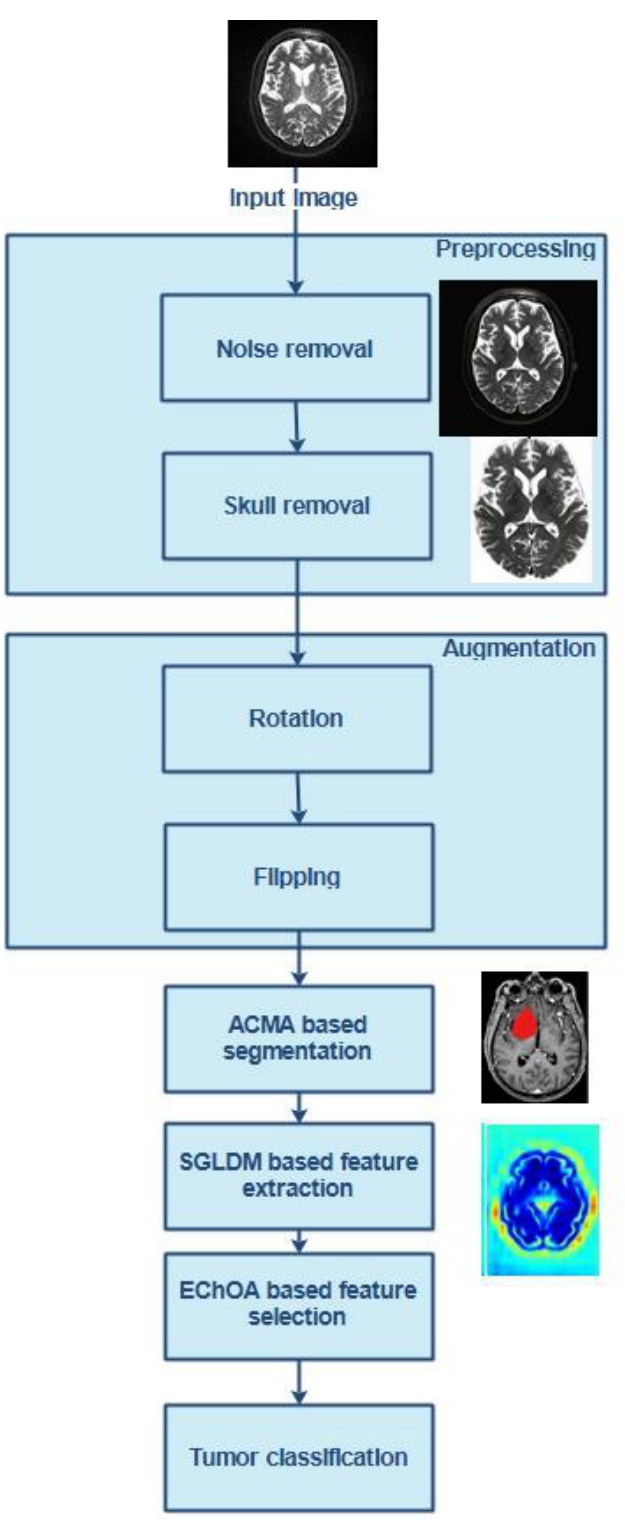
Figure 1. Overview of the tumor classification